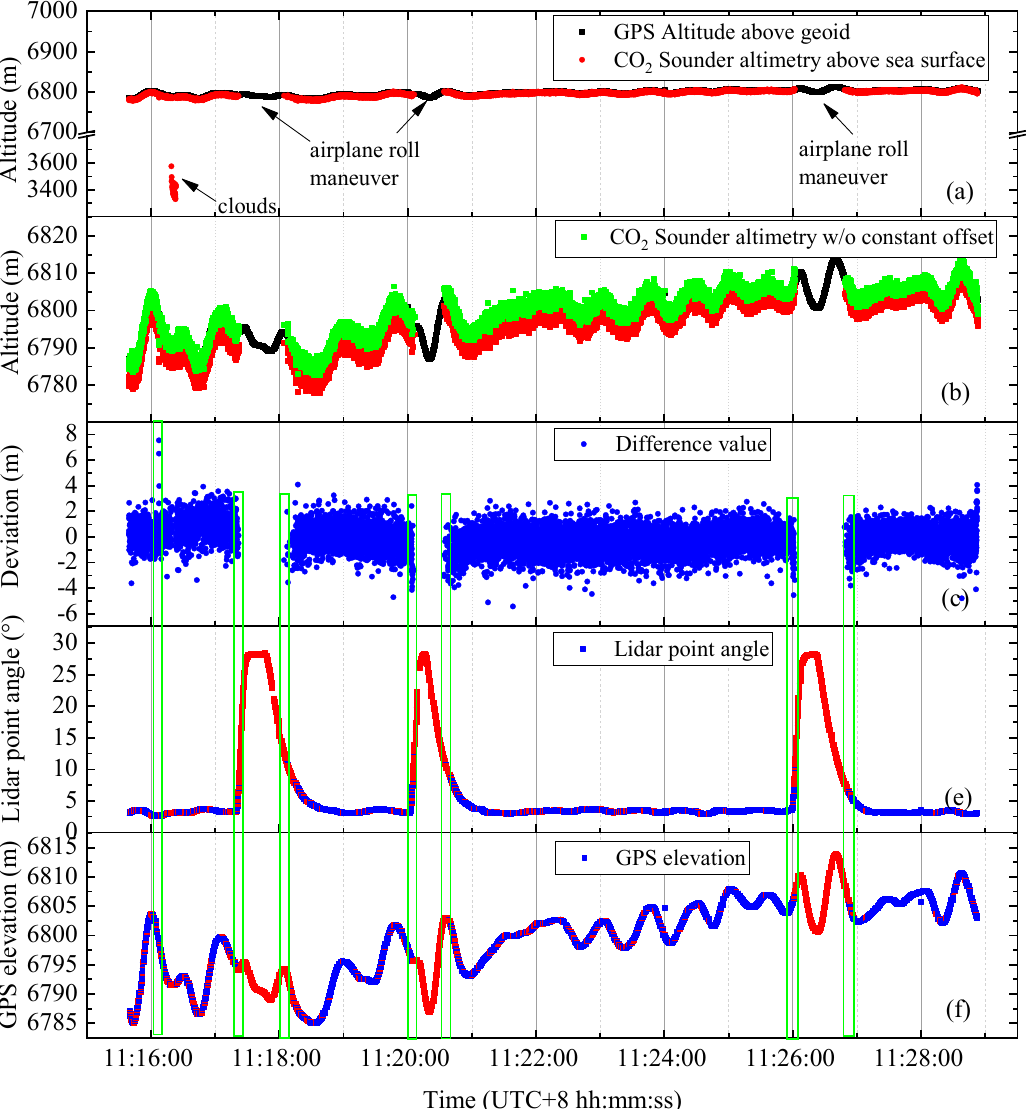
Figure 9. Results of data processing throughout the study area. ( a ) Results of our data processing on the whole sea level research area; the red dots represent the CO 2 optical column length results from the plane to the sea level, whereas the black dots represent the airborne GPS elevation detection data. The green points in ( b ) consist of two parts lengths. One part is the vertical length calculated by the geometric model after the atmospheric delay correction, and the other part is composed of sea level data from the tide station and the outliers of the single point elevation. The blue points in ( c ) represent the difference between the CO 2 column length corrected to vertical at each point and the elevation of the airborne GPS. The red points in ( d – f ) represent the distribution of Lidar pointing angle and GPS elevation in the whole study area, and the blue points represent the effective data that can be used to invert CO 2 column length.